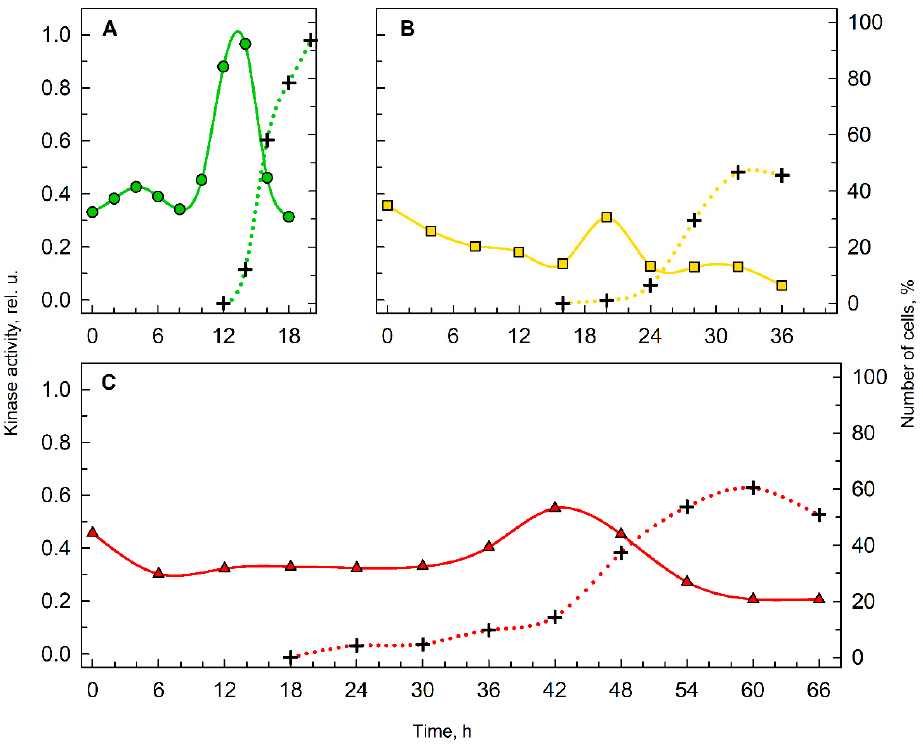
Figure 4. Histone H1 kinase activity in cultures grown in 0% D 2 O ( A ), 70% D 2 O ( B ) and 90% D 2 O ( C ). Kinase activity (solid line, left axis) precedes cell division (dotted line, right axis). One representative replica of the triplicate is shown for each condition.